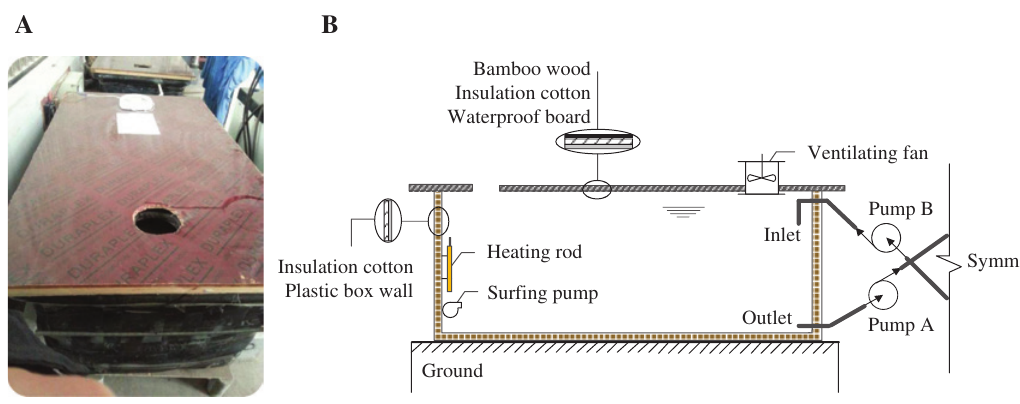
Figure 3: Automatic wet-dry cycling tanks. (A) Overview and (B) Schematic of the inner structure. BA